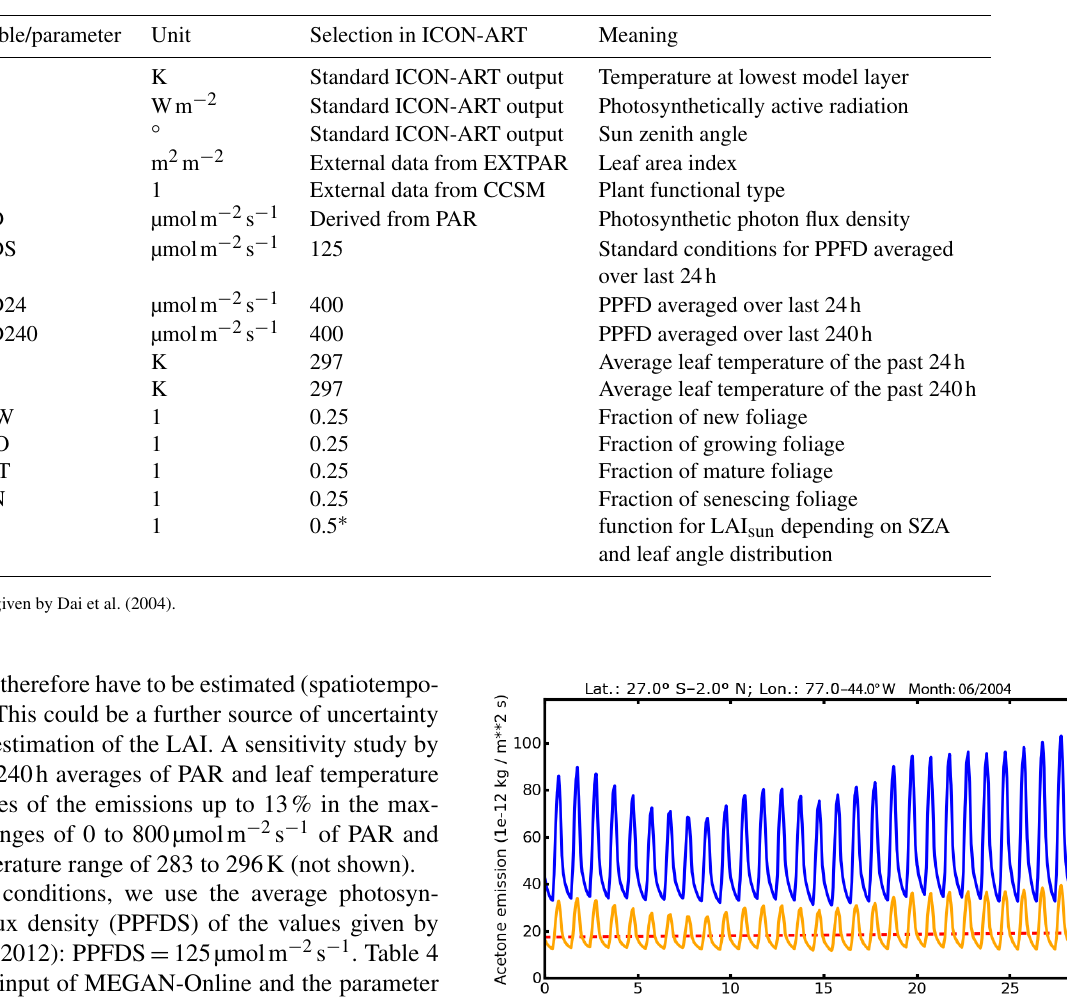
PPFD averaged over last 240h